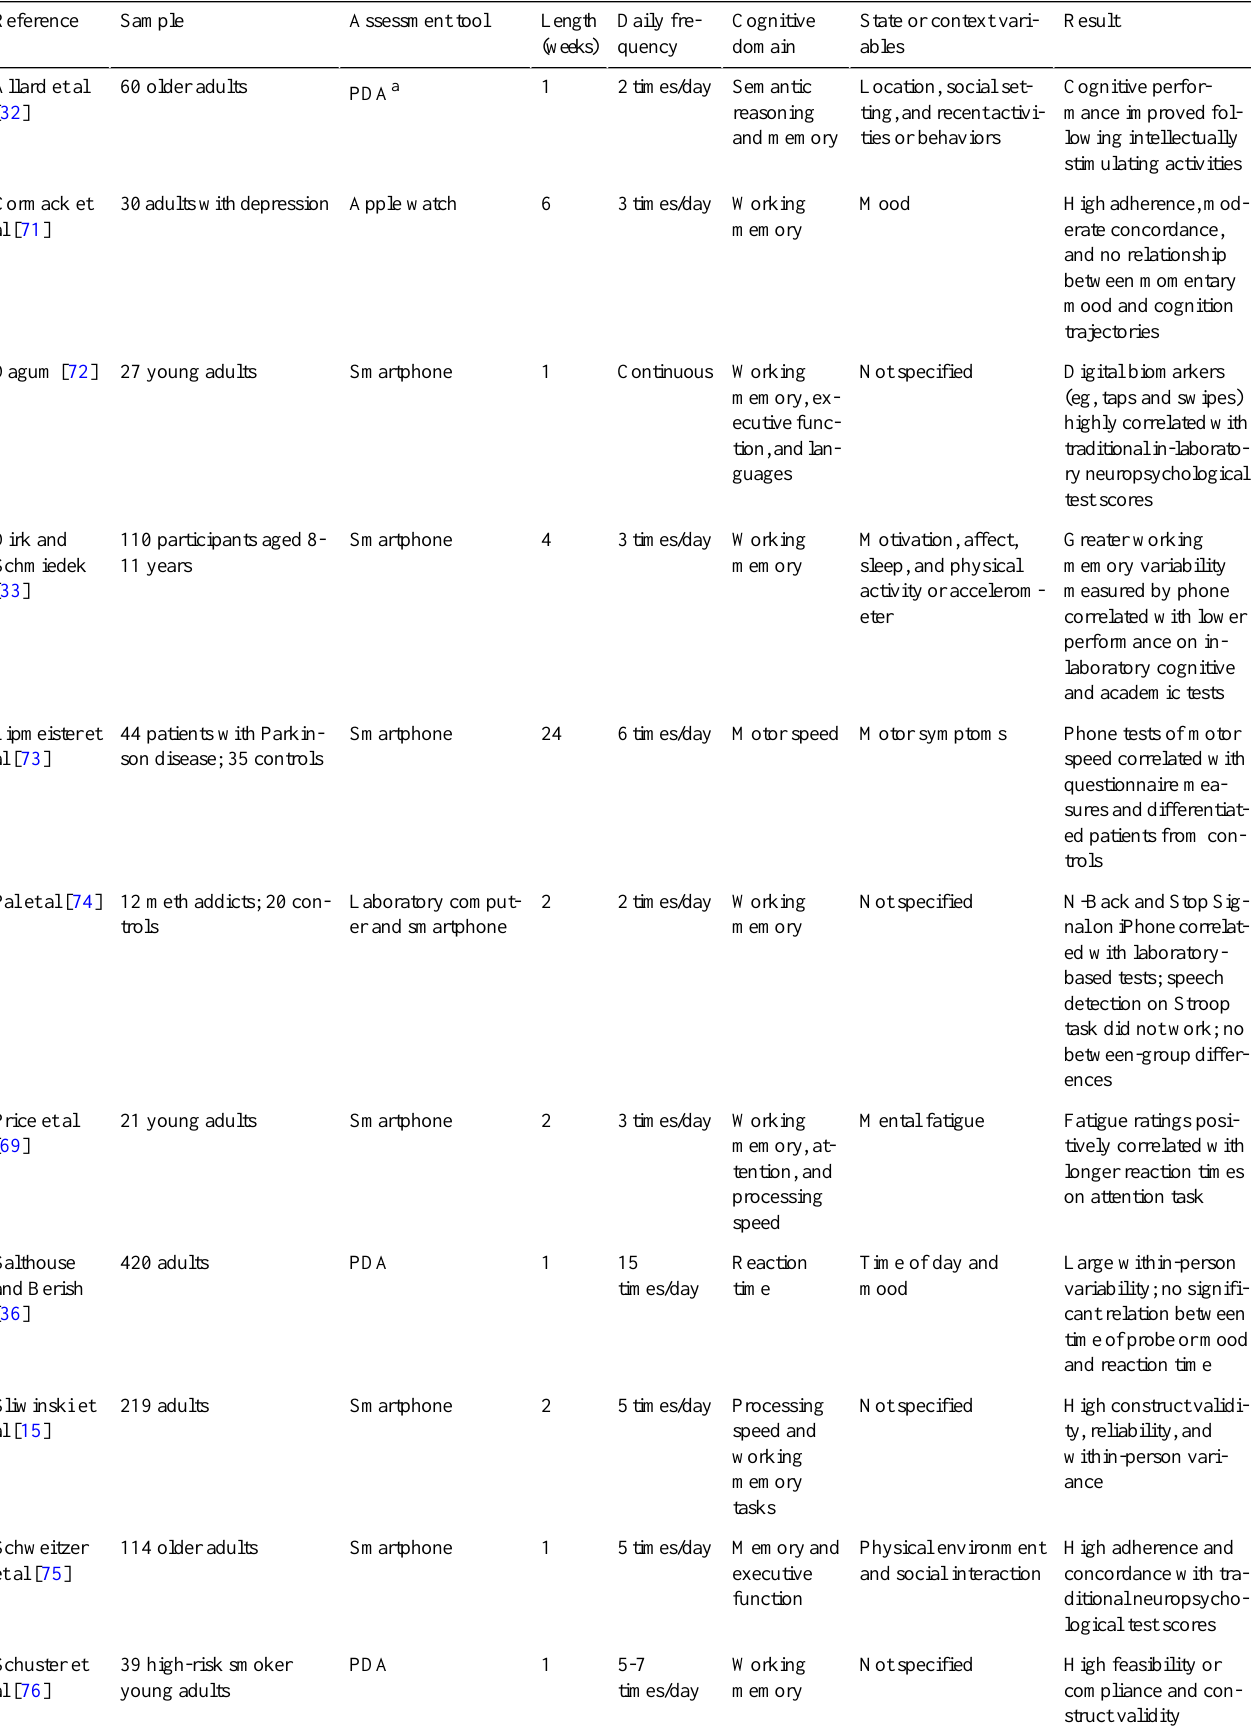
Table 2. Mobile assessment of